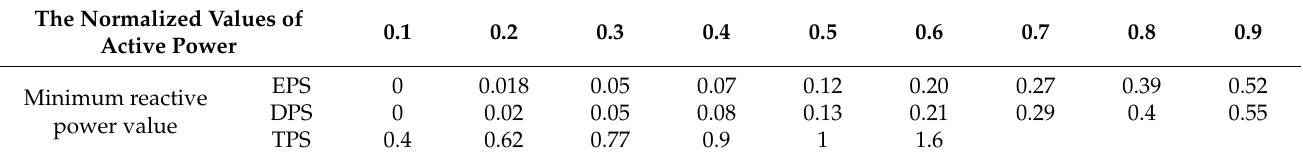
Table 1. The normalized value of active power and the minimum reactive power intersection